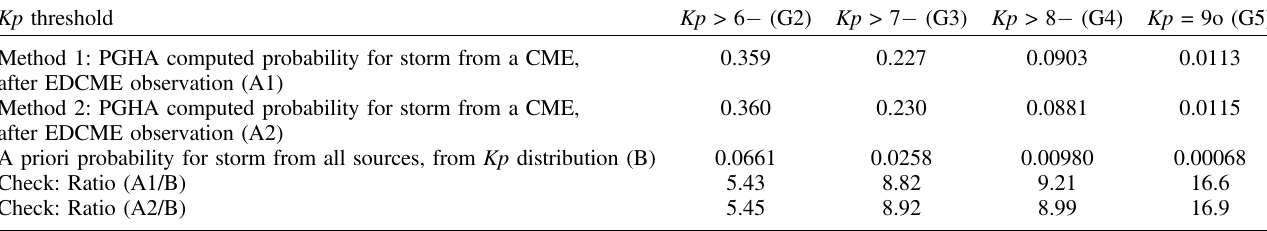
Table 2. Computed probability of Kp exceeding each threshold, post-observation of an EDCME, via the PGHA method via Method 1 and 2 (2nd and 3rd row respectively); the a priori probability of Kp above each threshold (4th row), and probability scaling factors, i.e. “ EDCME- observed/a priori ” (5th and 6th row). Since statistical uncertainty is not quanti fi ed, data have been rounded to three fi gures. Kp threshold Kp > 6 (cid:1) (G2) Kp > 7 (cid:1) (G3) Kp > 8 (cid:1) (G4) Kp = 9o (G5) Method 1: PGHA computed probability for storm from a CME, after EDCME observation (A1) Method 2: PGHA computed probability for storm from a CME, after EDCME observation (A2) A priori probability for storm from all sources, from Kp distribution